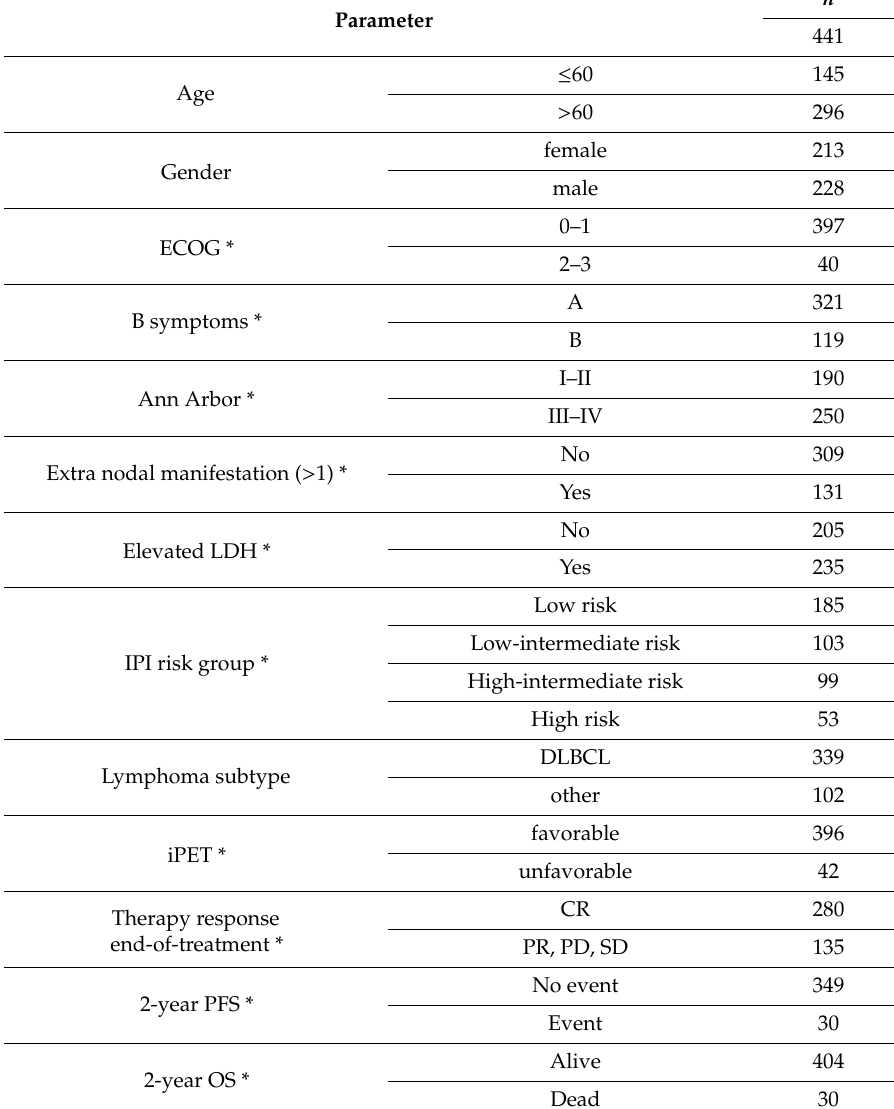
Table 3. Demographic profile of B-NHL patients. iPET (interim positron emission tomography); International Prognostic Index (IPI) stratifying patients in four risk groups (0–1 factor positive = low risk, 2 factors positive = low-intermediate risk, 3 factors positive = high-intermediate risk, 4–5 factors positive = high risk); ECOG performance status (0–1, 2–3); B symptoms (A = no B symptoms; B ≥ 1 B symptom including fever > 38 ◦ C, drenching night sweats, weight loss > 10 kg); di ff use large B-cell lymphoma (DLBCL); other included: follicular lymphoma (FL) with FL grade 1–2, grade 3 with areas of grades 1 or 2, grade 3; primary mediastinal B-cell lymphoma (PMBL); mantle cell lymphoma, unclassified B-cell lymphoma and mixed histologies; complete remission (CR), partial remission (PR), progressive disease (PD), stable disease (SD); progression-free survival (PFS); overall survival